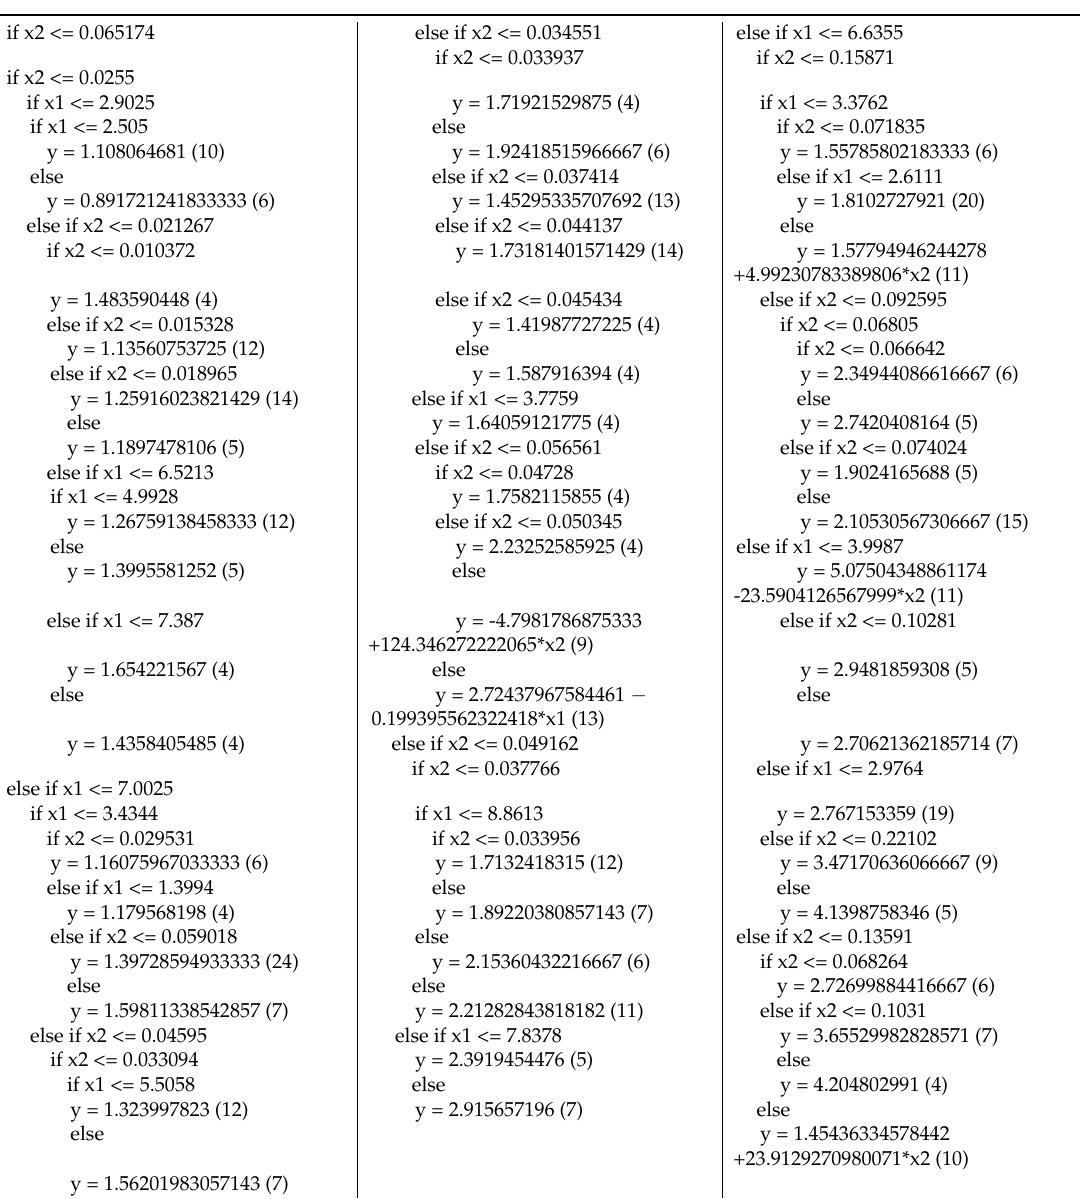
Table A1. Regression tree obtained from M5Tree for strength